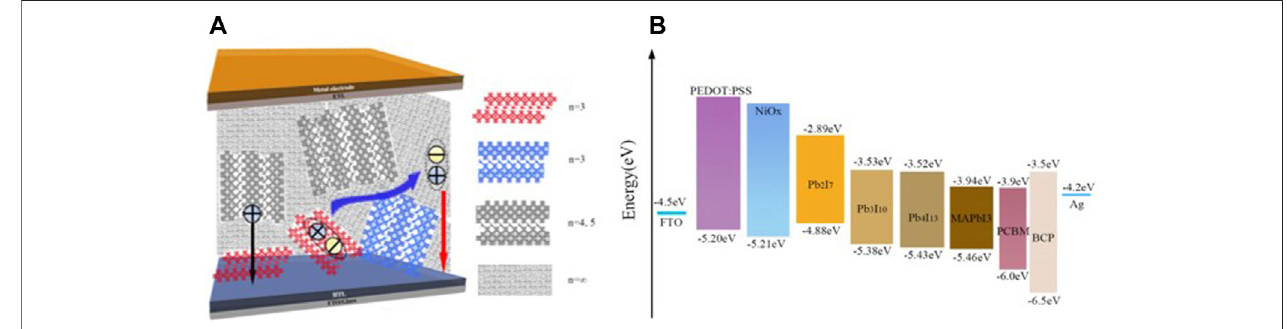
FIGURE7|(A) Excitationsandcharge carriertransportmechanism inthe2DRPPperovskite fi lm. (B) Energy diagram fordeviceswithinverted PSCcon fi guration.